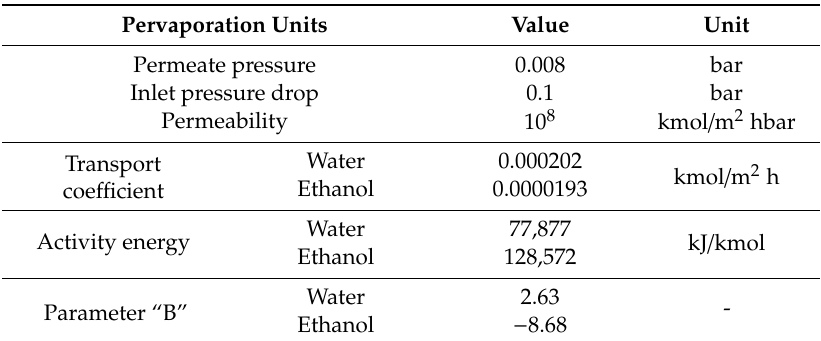
Table 2. Hydrophilic pervaporation membrane parameters of ethanol-water mixture (PERVAP ™ 1210 type membrane) [74].